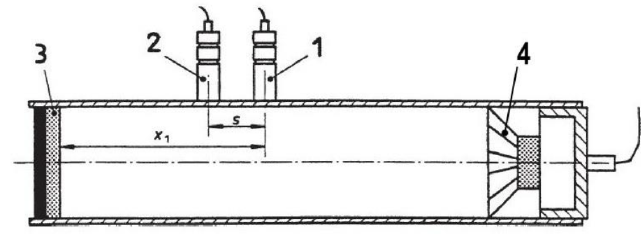
Figure 3. Impedance measuring tube according to